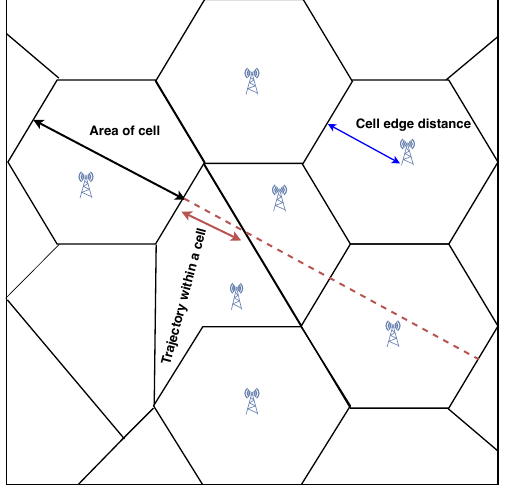
Figure 4. Handover skipping.